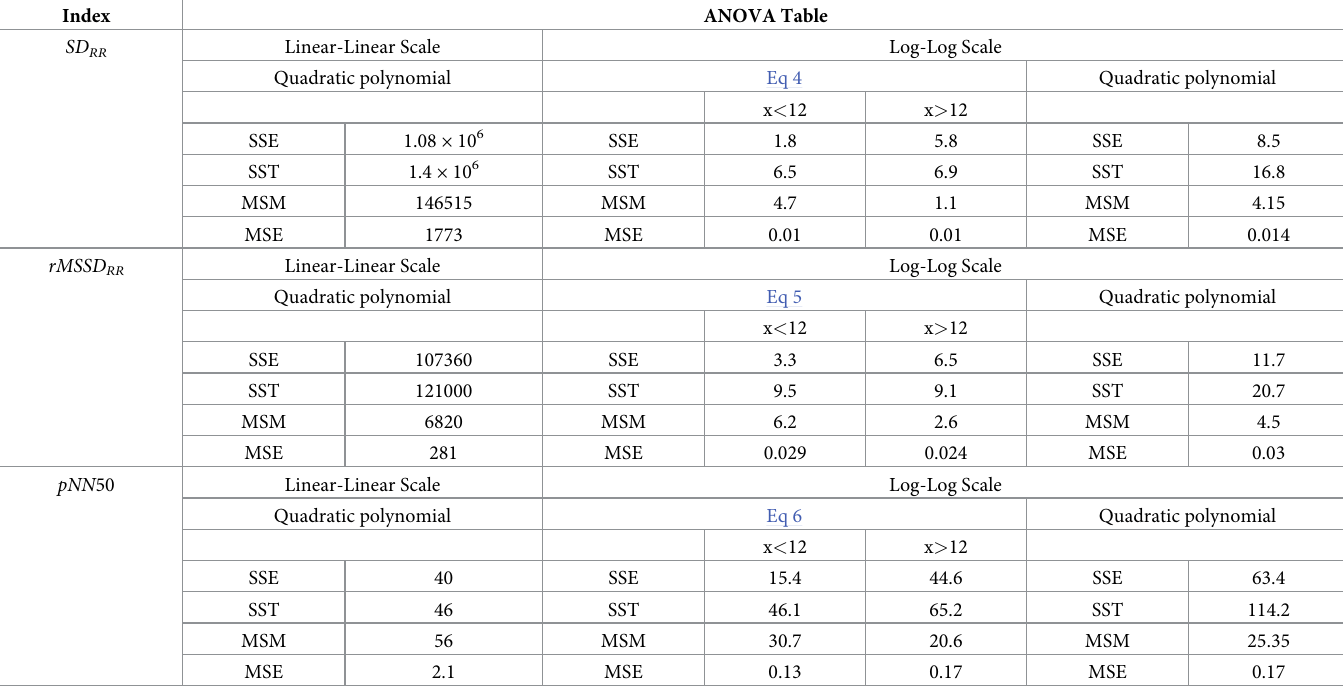
Table 8. ANOVA tables for different fits over the complete data set tested in this